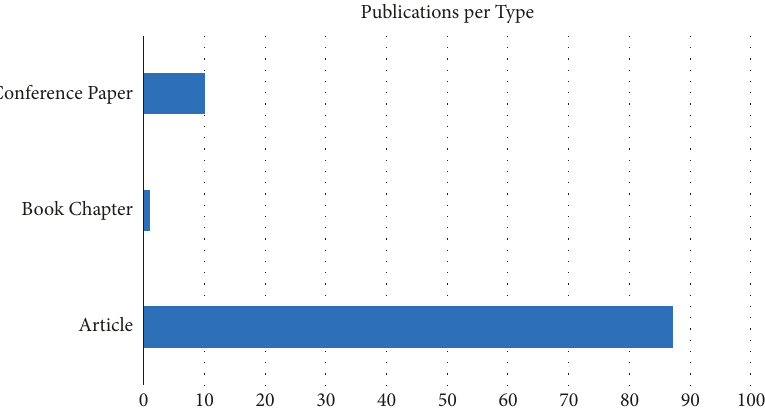
Figure 2: Publications reviewed in this work are categorized by their typologies.